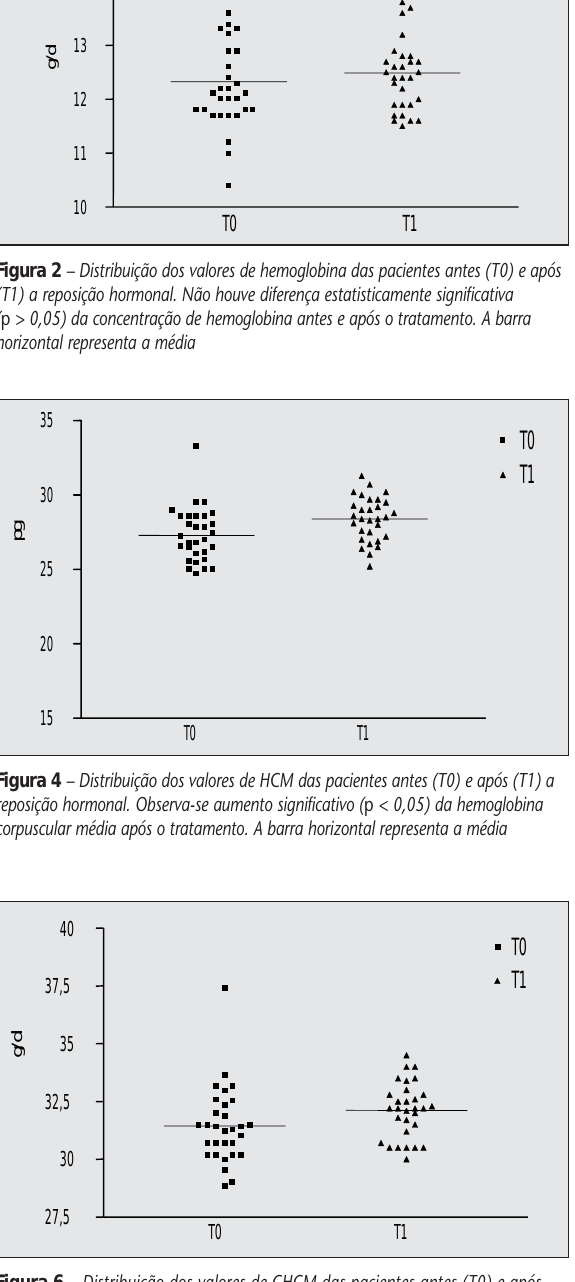
Figura 5 – Distribuição dos valores de VCM das pacientes antes (T0) e após (T1) a reposição hormonal. Observa-se aumento significativo ( p < 0,05) do volume corpuscular médio após o tratamento. A barra horizontal representa a